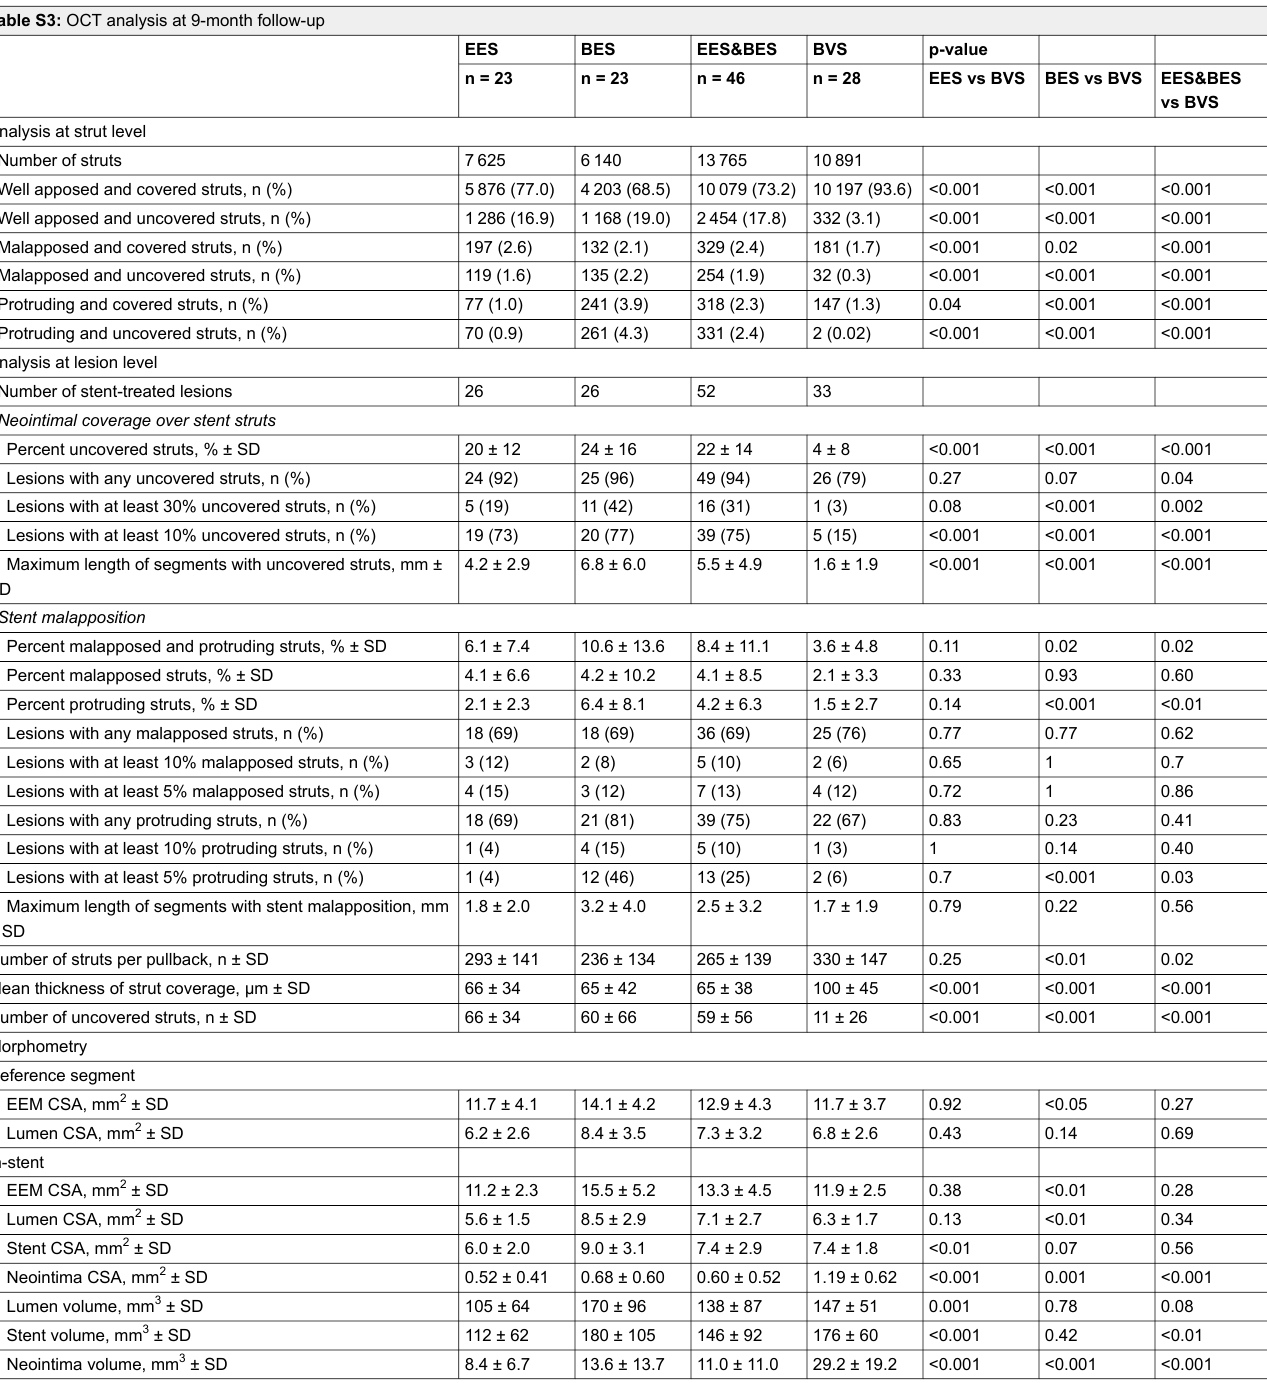
Table S3: OCT analysis at 9-month